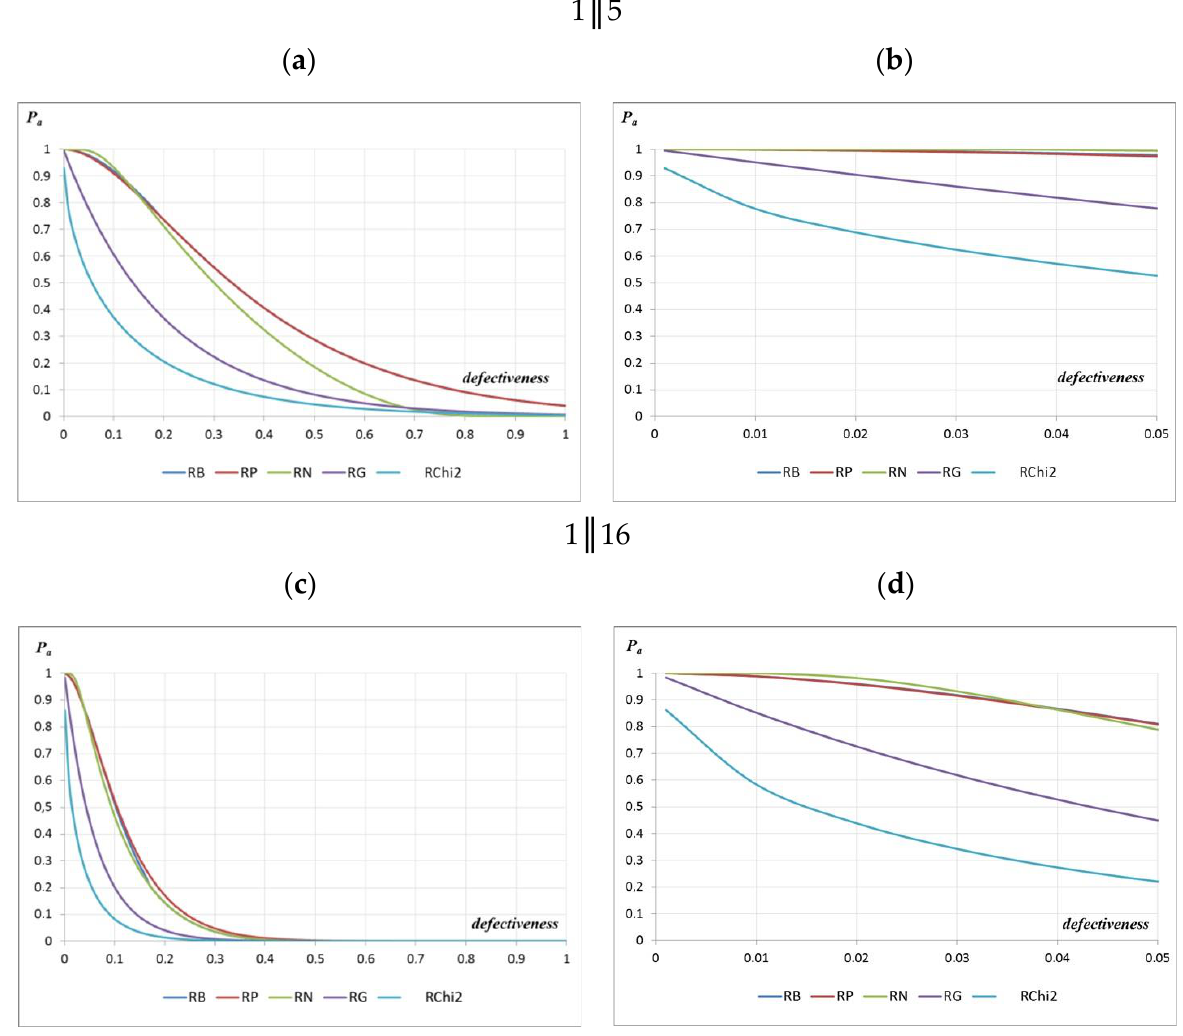
Figure 13. OC curves for testing plans: (a) 1 ║ 5 and (b) 1 ║ 5; 1 ║ 16 (c) 1 ║ 16 and (d) 1 ║ 16. Table 1. The values of the acceptance probability estimated for various acceptance plans related to normal control and the transition from strict to normal control of the considered precast concrete products.